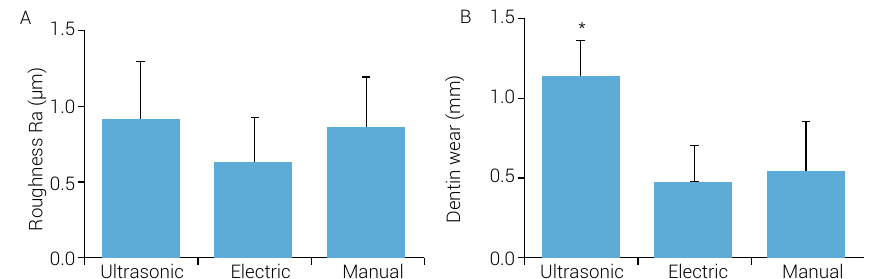
Figure 3. Representative graphs of the dentin A) roughness and B) wear data. It´s possible to note that the US presented higher dentin wear than the other groups. *p<0.05-Higher dentin wear than the other groups- One-way Anova complemented by